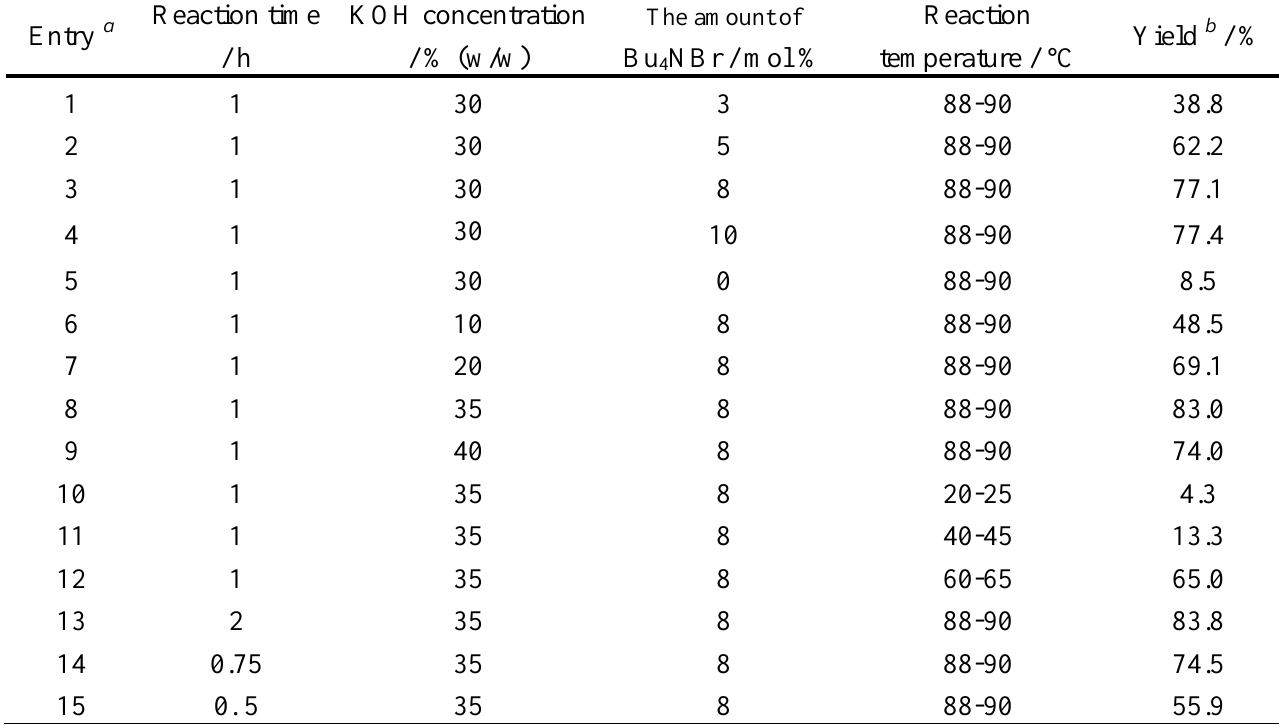
Table 1 Different reaction conditions for synthesis of 3e